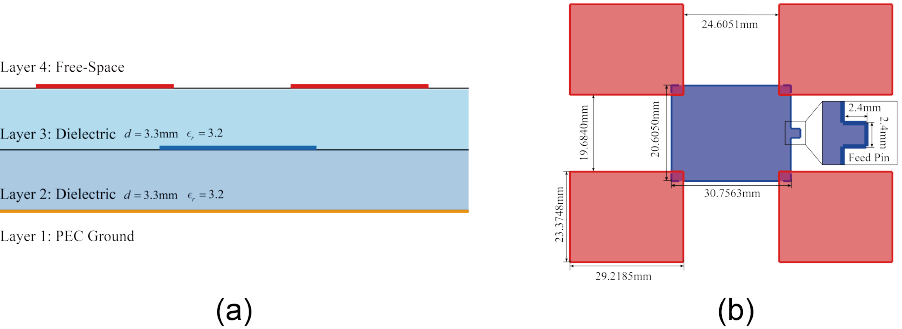
Figure 9. A stacked antenna, ( a ) layered medium configuration, ( b ) antenna metallization geometry.